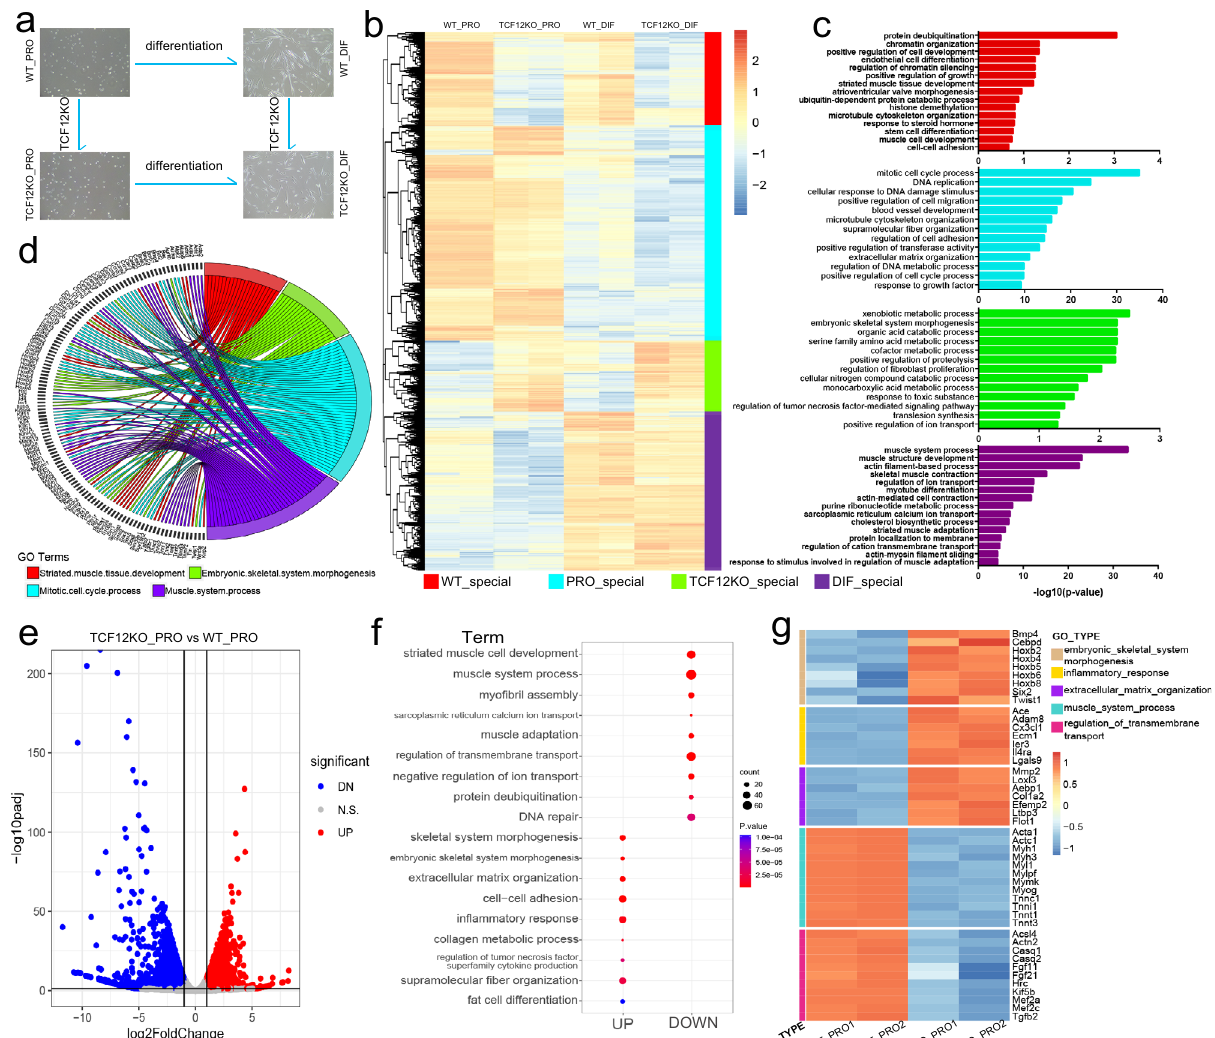
Fig. 3 TCF12 deletion activates non-muscle gene programming in MuSCs. ( a ) Schematic outline for comparing the gene expression patterns between different types of muscle cells, including Ctrl (WT_PRO and WT_DIF) and TCF12KO (TCFKO_PRO and TCFKO_DIF) cells; ( b ) Heatmap demonstrating different transcriptional patterns in each cell type after cluster analysis. Only genes expressed at least in one stage or group (TPM ≥ 1) were included; Note the WT special (red), TCF12KO special (green), proliferation special (blue), differentiation special (purple) upregulated genes were marked; ( c ) GO analysis of upregulated genes in the four types of cell-to-cell comparisons; ( d ) Circus plot showing the cell-speci fi c biological process-related genes; the selected DEGs revealed the aberrant induced biological processes in muscle cells after Tcf12 deletion, especially the functions involved in embryonic skeletal system morphogenesis; ( e ) Volcano plot of the RNA-seq data of TCF12KO_PRO versus WT_PRO cells. Signi fi cantly upregulated (red) and downregulated (blue) genes are highlighted (|logFC|> 2, P value < 0.01); ( f ) GO analysis of signi fi cantly dysregulated genes in WT_PRO and TCFKO_PRO cells. Biological processes were selected based on the count of gene number (gene count > 10) and P value ( P value <1 × 10 − 10 ); ( g ) Heatmap with the normalized reads per gene of WT_PRO and TCFKO_PRO